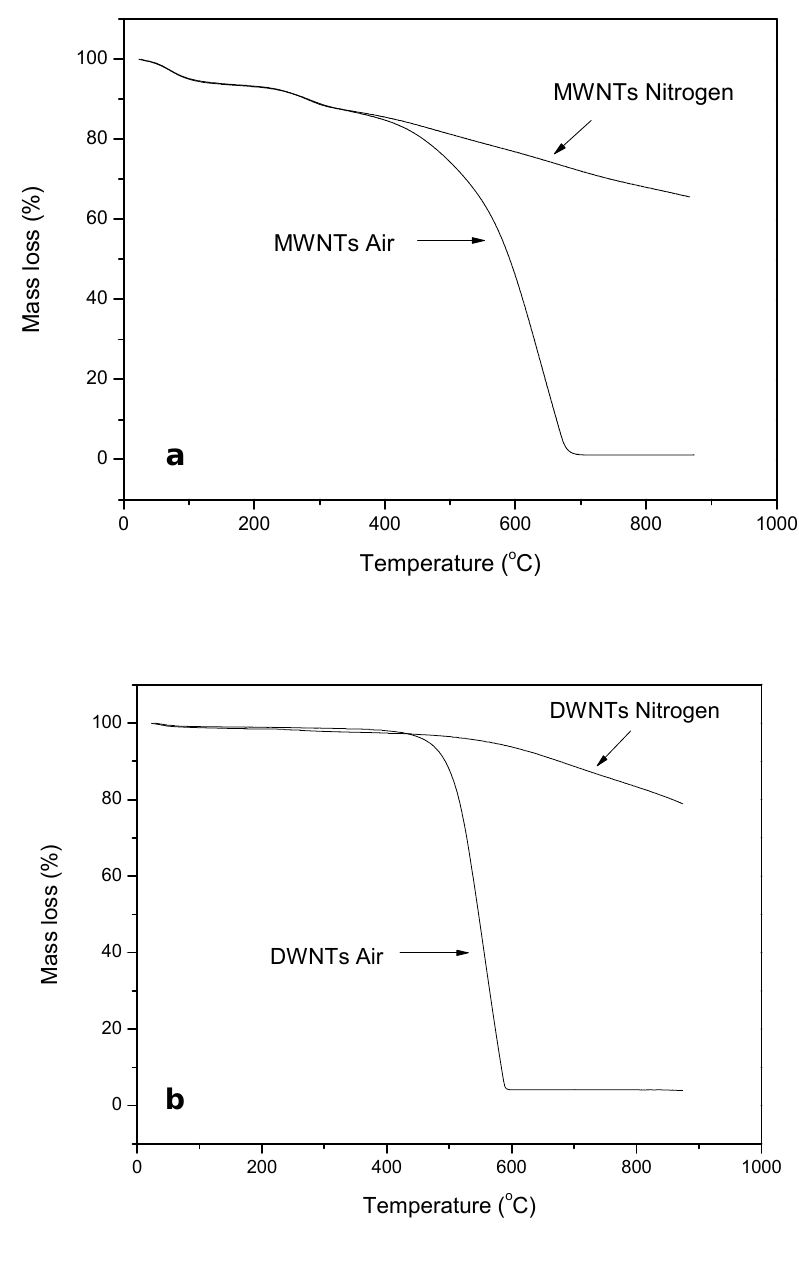
Figure 31. TG and DTG curves in air of MWCNTs and